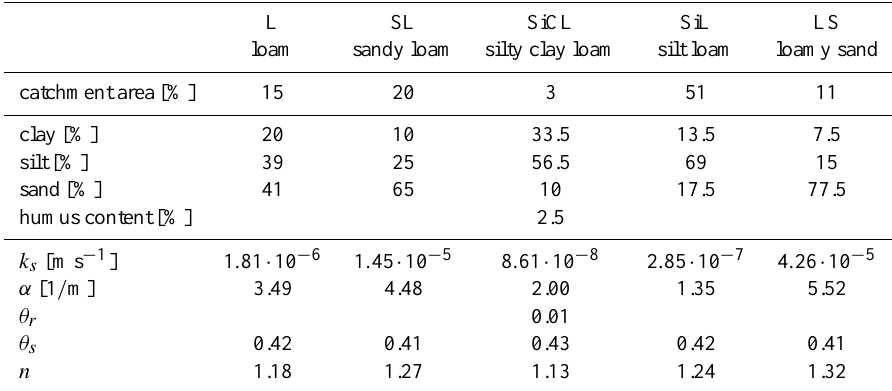
Table 8. Expectation values of the physical properties of the prevailing soil types in the Rietholzbach catchment, classified according to USDA, and corresponding soil hydraulic parameters; the parameterisation of the soil hydraulic parameters is done for each soil according to the approach provided in Grundmann (2010) by the help of the pedotransfer functions provided in W¨osten et al. (1999) and Brakensiek et al. (1984); the expectation values are the mean over 10000 realisations L